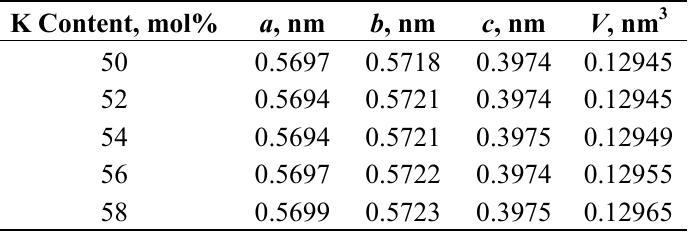
Table 1. KNbO (KN) crystals’ starting composition dependence of lattice parameters, a , 3 b , c , and lattice volume, V , reprinted with permission from [24]. Copyright 2006 Elsevier . K Content,